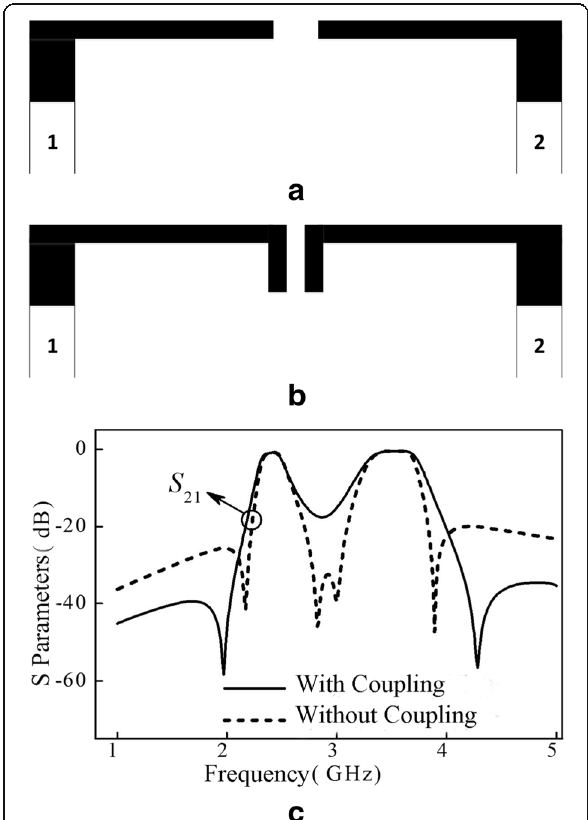
Fig. 4 Source-load coupling. a The structure characteristic without the source-load coupling technique. b The structure characteristic with the source-load coupling technique. c The comparison of S parameters between with and without source-load